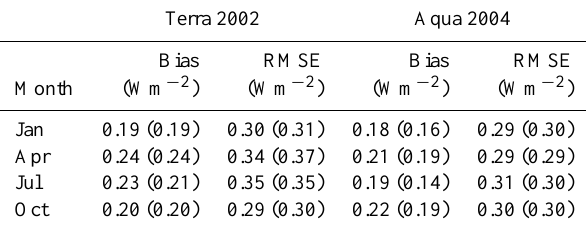
Table 3. Regional mean TOA WN flux bias and RMSE by season derived from direct integration, using ADMs developed by Su et al. (2015) for the Edition 4 SSF data, and ADMs developed by Loeb et al. (2005) for the Edition 3 SSF data (shown in parentheses) for Terra 2002 and Aqua